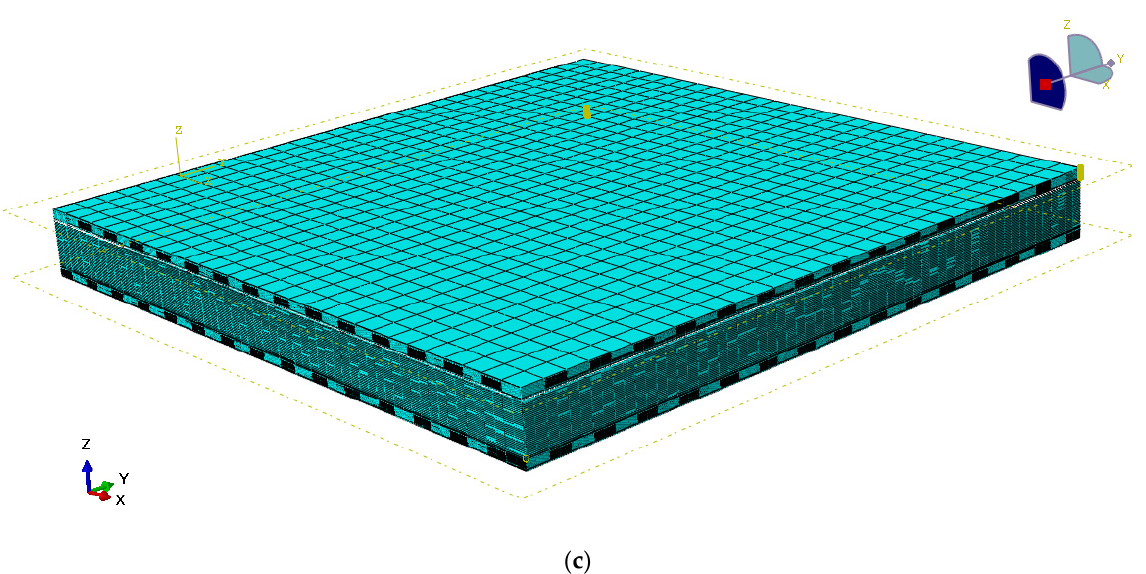
Figure 2. ( a ) The geometry of the functionally graded material (FGM) sandwich plate resting on an elastic foundation. ( b ) Simply supported boundary conditions are imposed on four edges. ( c ) Meshed model of the sandwiched plate showing the subdivisions in the FGM cover plates.